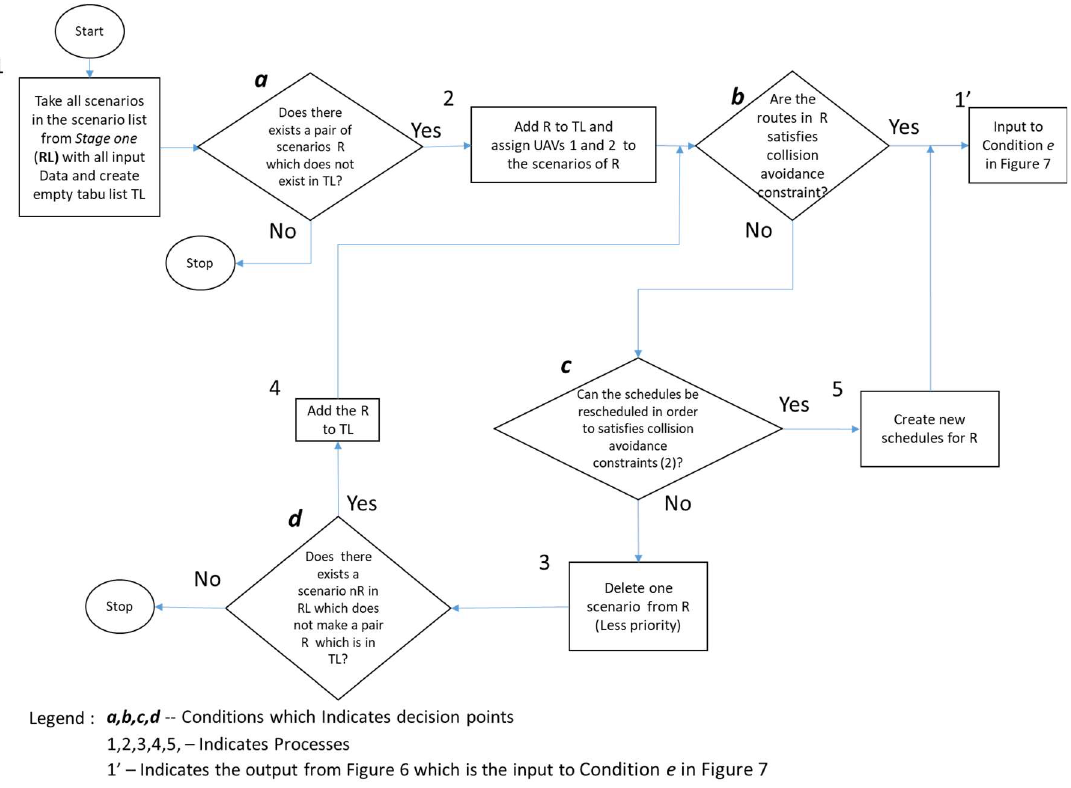
Figure 6. The heuristic to create sub-missions with collision avoidance for a cluster in an FTW.